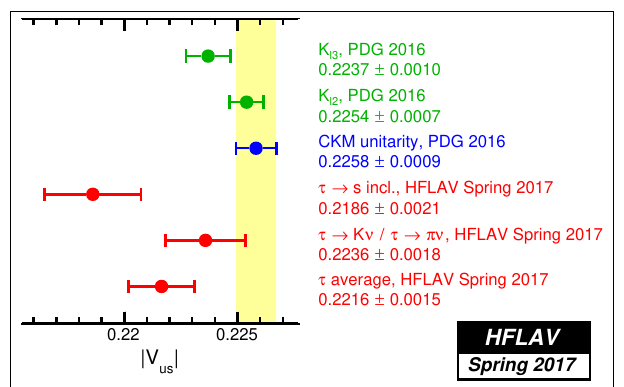
Figure 2. V us computed using the τ | | measurements compared to the determinations based on the CKM matrix unitarity and on the kaon branching